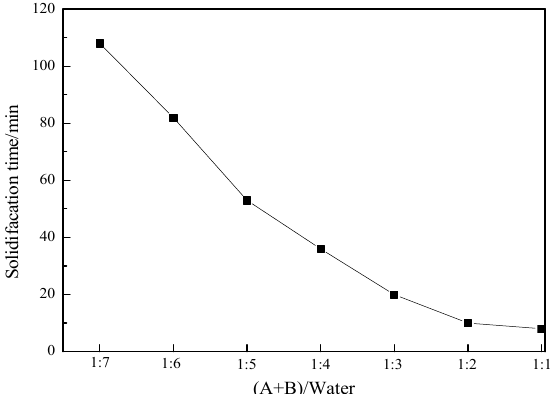
Figure 5. Solidification times with different ratios of high polymer and water.